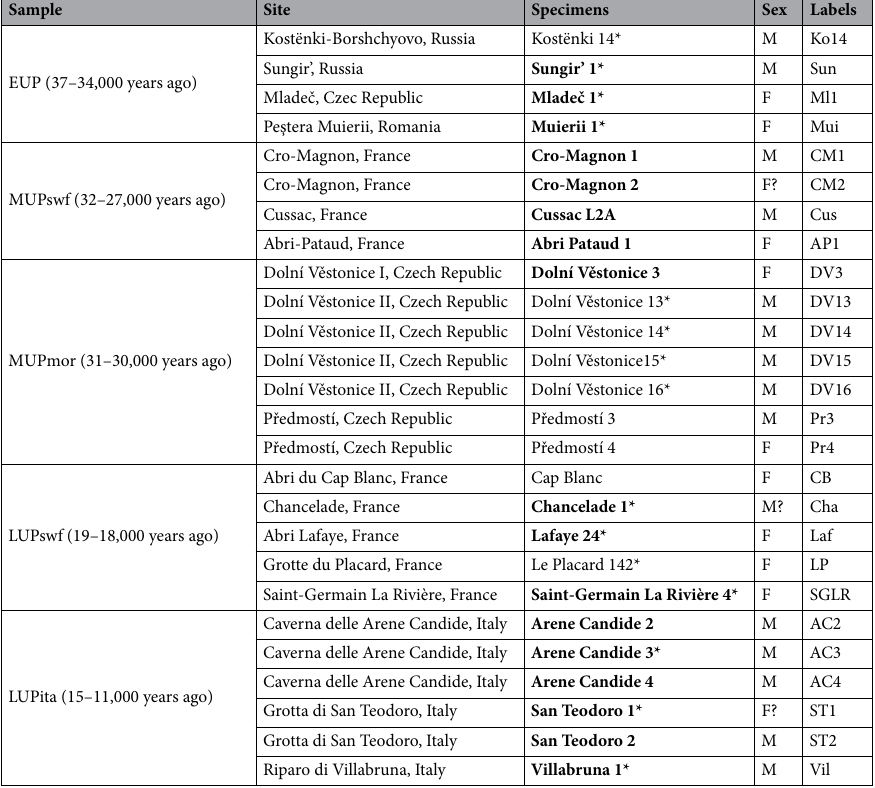
Table 1. Fossil specimens included in the study. More information on the sample can be found in the online supplementary material (Supplementary Table S1). Specimens in bold: data from the original fossils. *Direct dating of the